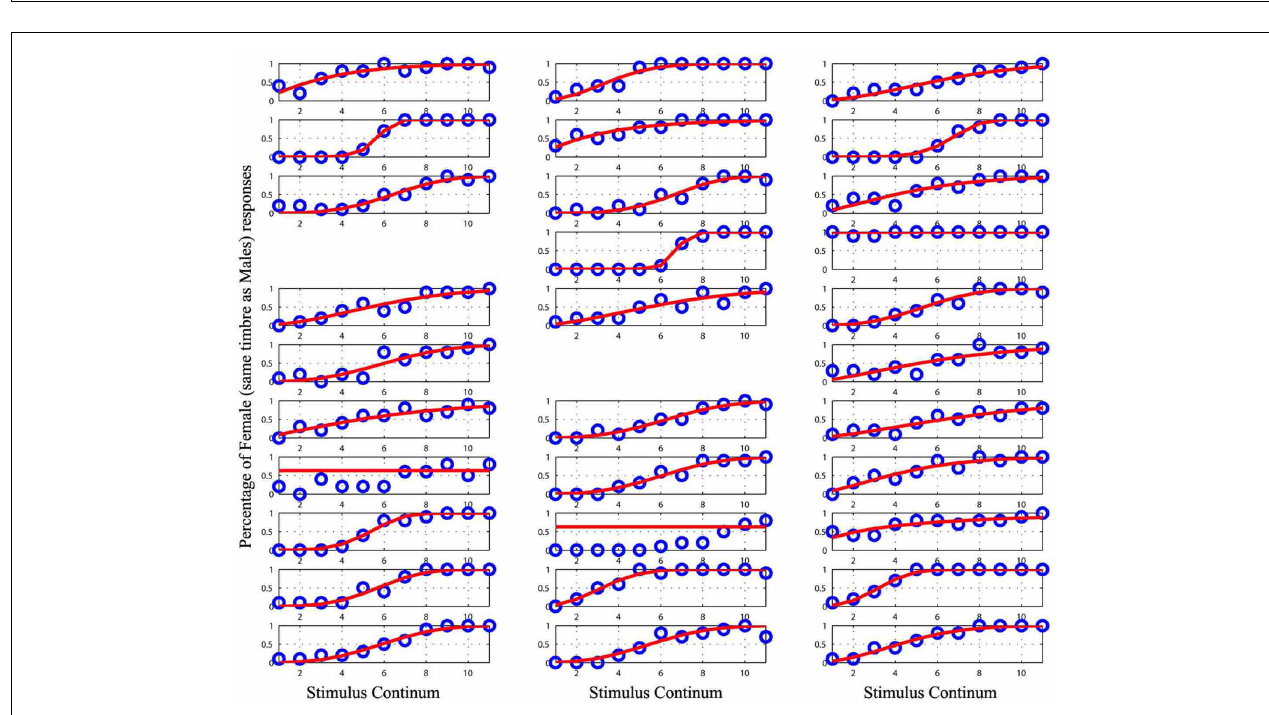
FIGURE 5 | Plot of the raw data (blue circles) and the cumulativeWeibull function (red lines) for each subject in the male/female condition with equalized timbre. Empty spaces mark missing data for subject 10 and 17. Data from the subject 1, 12, 22, 26, and 27 were removed from the analyses as they could not be